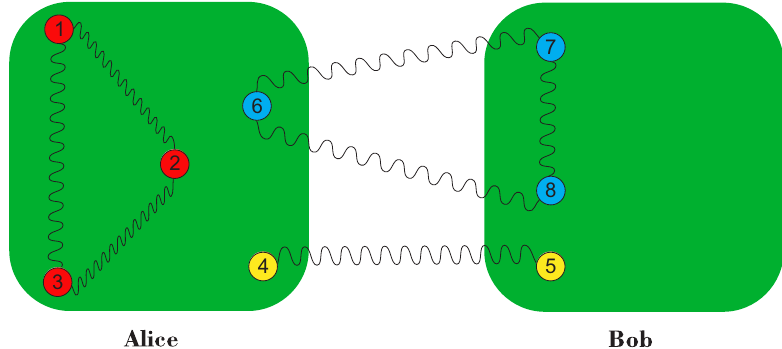
Figure 8. A possible way of teleporting a W state is illustrated. A GHZ state and an EPR channel are used as the quantum